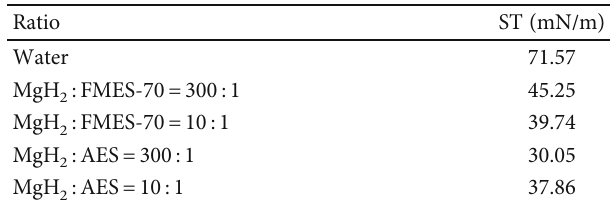
Figure 3: The e ff ect of di ff erent FMES-70, AES dosages on hydrogen generation. Table 2: Surface tension values of aqueous solutions with di ff erent FMES-70, AES dosages.